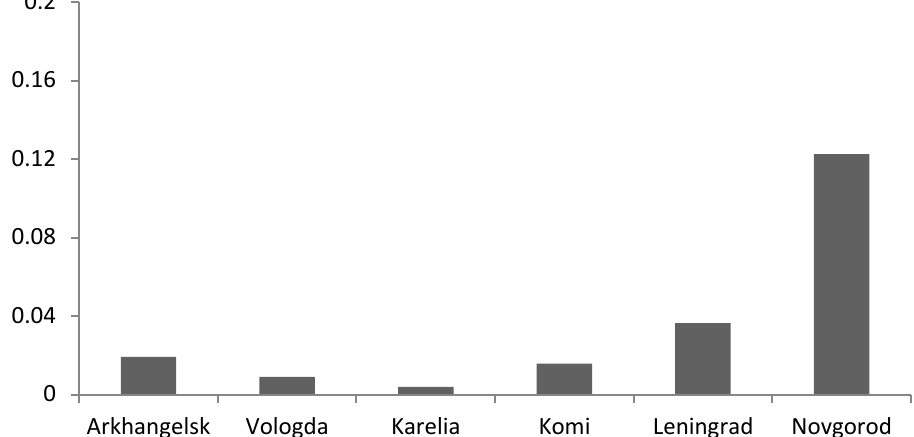
Figure 2. Total number of minor NCs per 1000 ha of certified forests among regions in 2015.